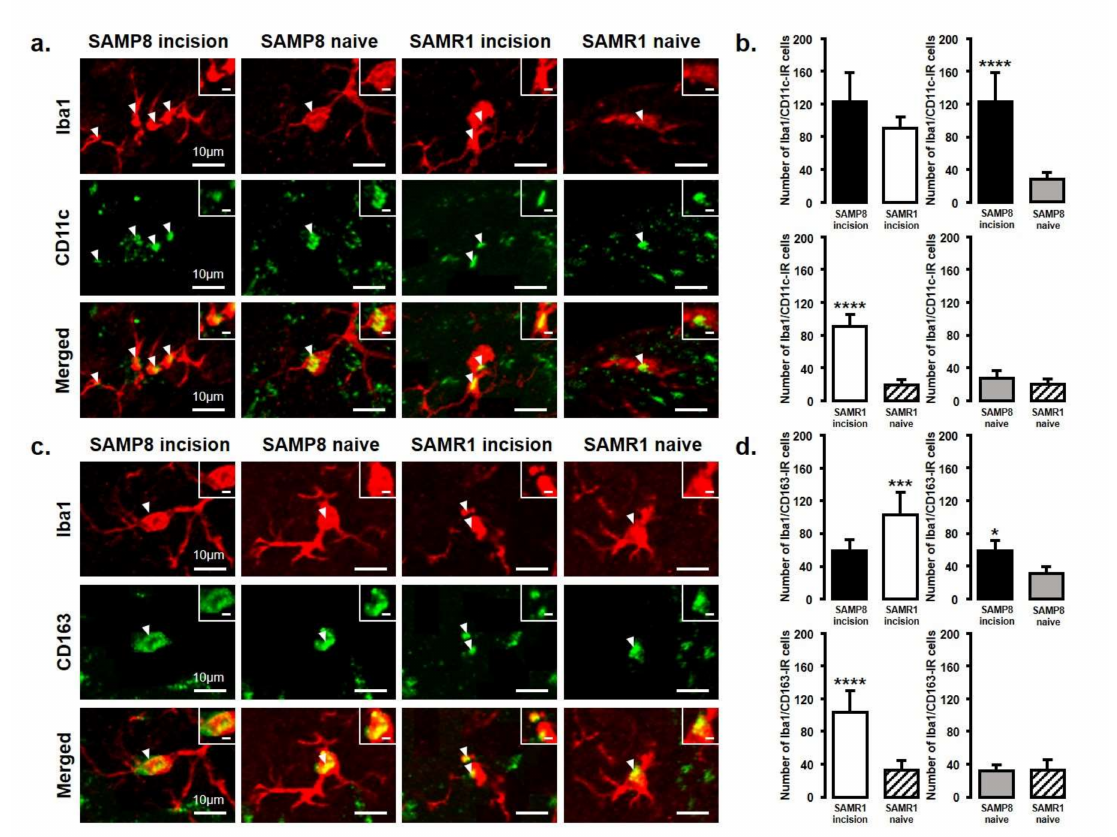
Figure 4. M1 / M2 polarization in microglia in the Vc and C1 / C2 regions on day 11 after palatal mucosal incision. ( a ) Low and high (inset) magnification photomicrographs of Iba1-IR cells (red), CD11c-IR cells (green), and Iba1-IR / CD11c-IR cells in the Vc and C1 / C2 regions on day 11 after palatal